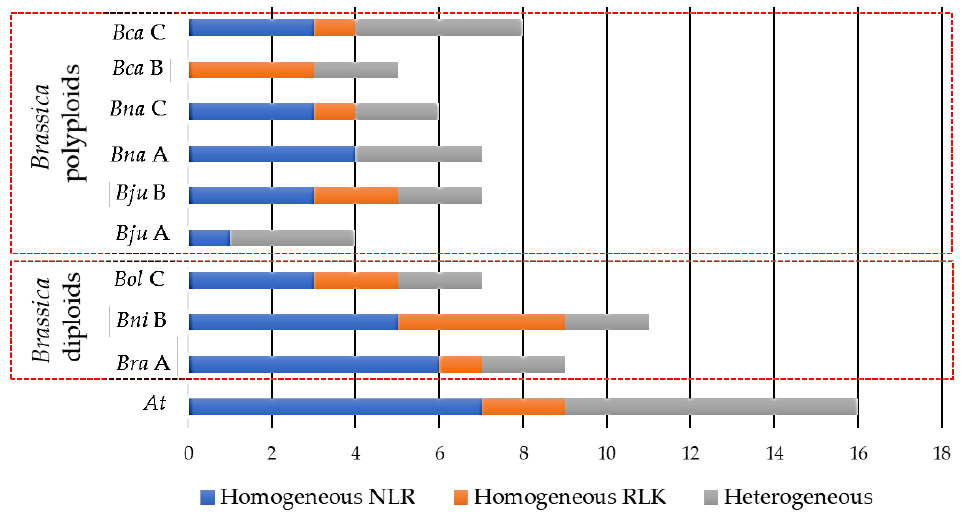
Figure 2. Distribution of gene clusters of cloned disease resistance homologs in Brassica rapa ( Bra ), B. nigra ( Bni ), B. oleracea ( Bol ), B. juncea ( Bju ), B. napus ( Bna ), B. carinata ( Bca ), and Arabidopsis thaliana (At) . NLR is nucleotide-binding site (NBS)- leucine rice repeats (LRR) while an RLK is receptor-like kinase proteins. A, B, and C refer to the genome/sub-genome of Brassica species.